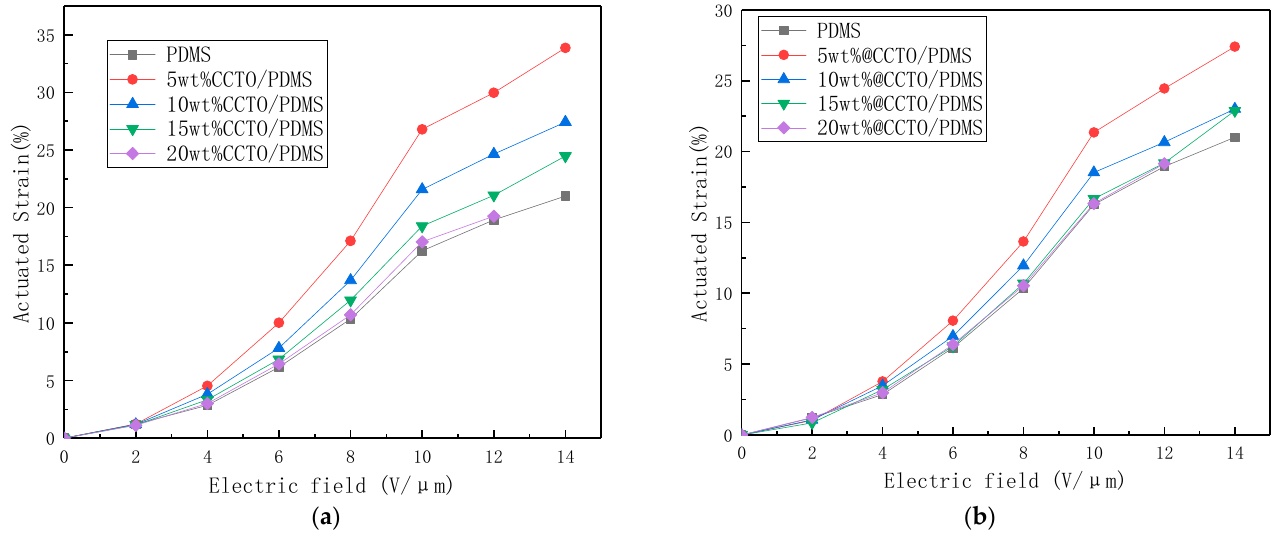
Figure 14. Electrostrain diagram of PDMS and different contents of CCTO ( a ) and @CCTO ( b ) filled PDMS